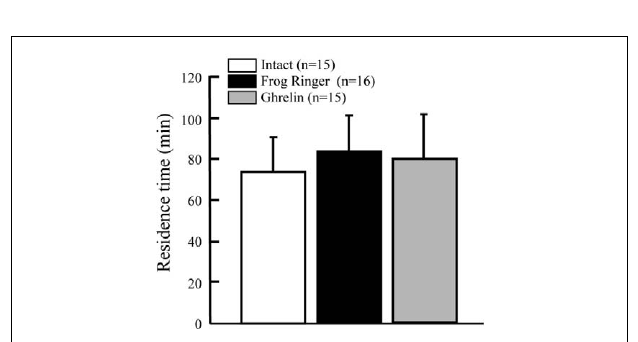
FIGURE 10 | Effect of intracerebroventricular injection of rat ghrelin on residence time in water of Japanese tree frogs. Values are the means + SEM. Statistical analysis (non-repeated ANOVA followed by Bonferroni/Dunn test) was conducted, but significant difference was not